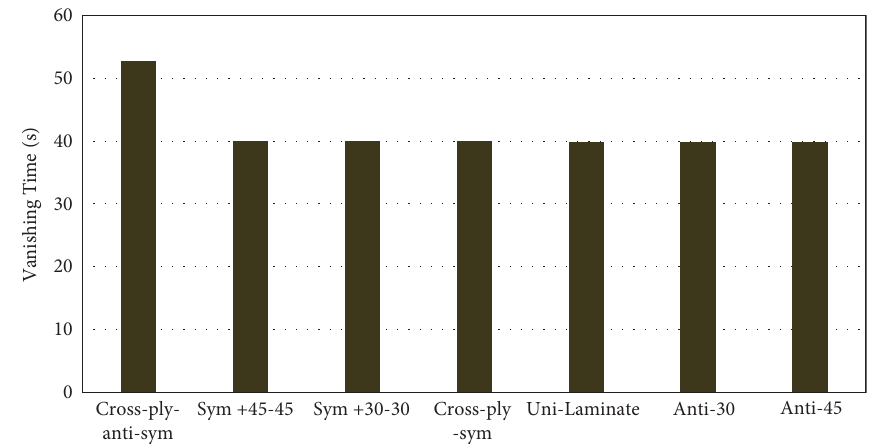
Figure 4: Presentation of the time elapsed till the vibration